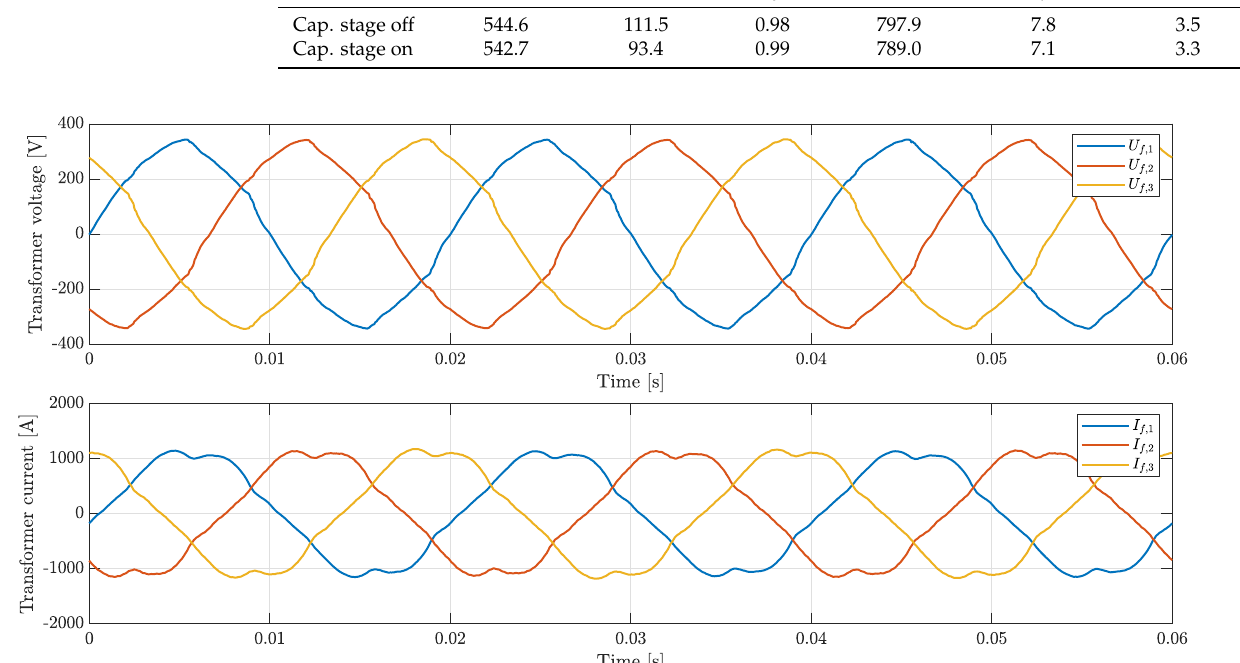
Figure 8. C1—Secondary voltage and current of transformer T1 before switching on the capacitor